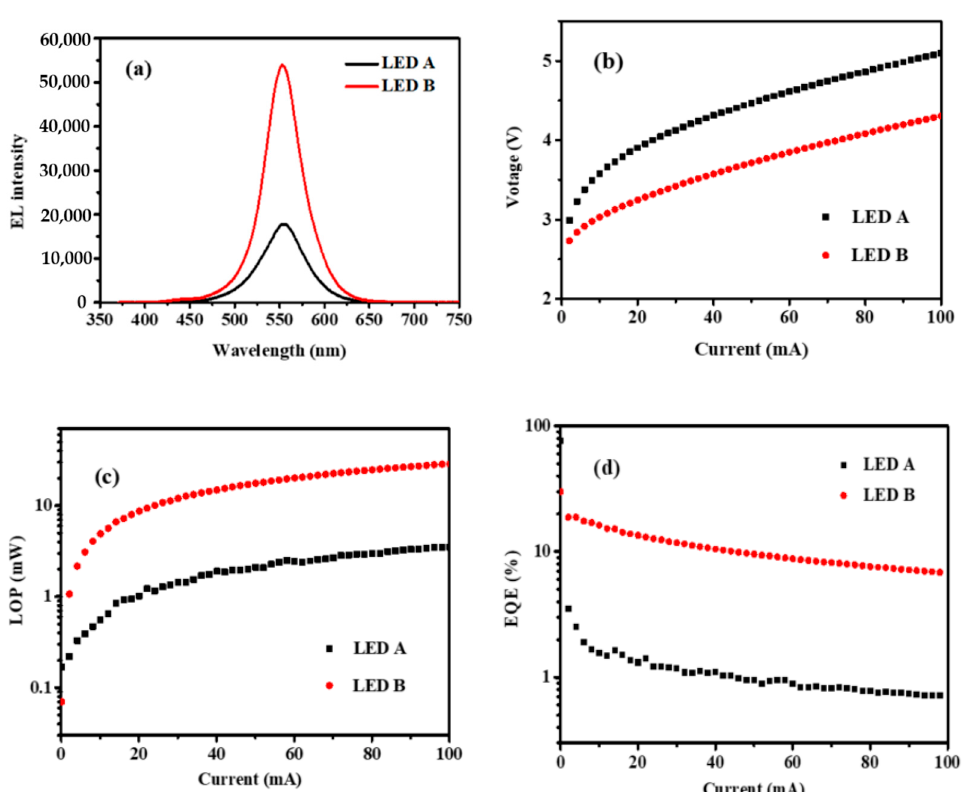
Figure 4. ( a ) Electroluminescence (EL) spectra, ( b ) Voltage, ( c ) light output power (LOP), and ( d ) external quantum efficiency (EQE) as a function of the injection direct current of the green-yellow LED, respectively.